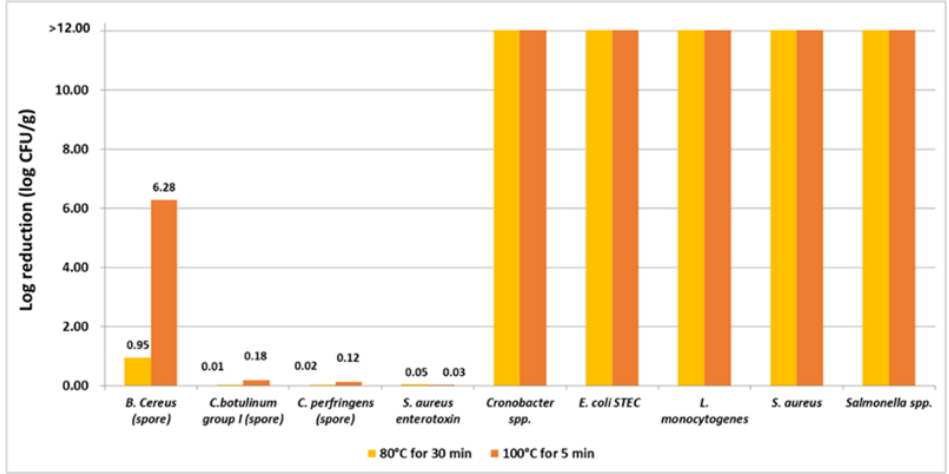
Figure 3. Log reduction of significant hazards estimated with D ref values for heat treatments.